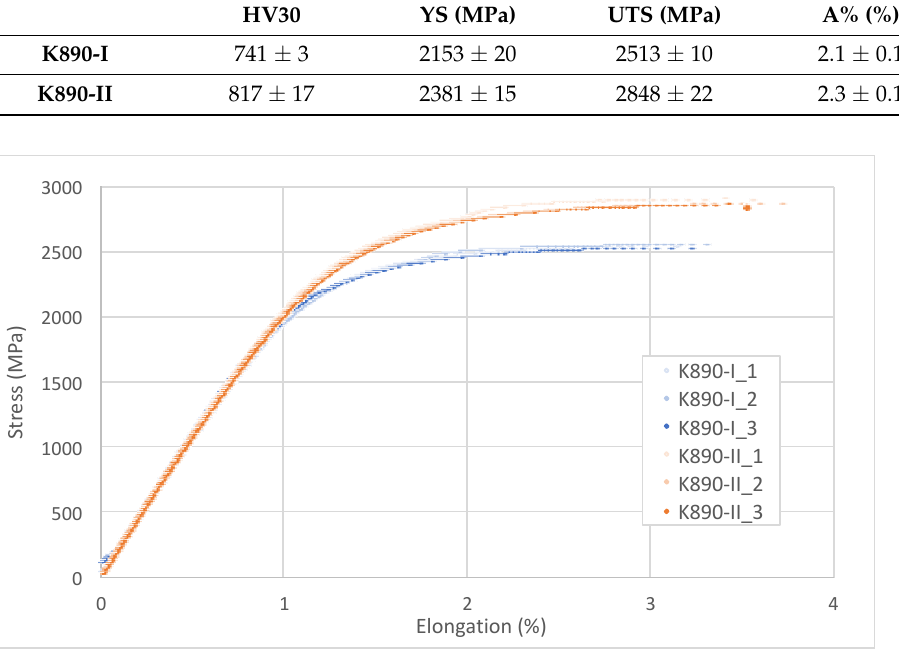
Table 2. Hardness and tensile properties (mean values and standard deviations) of the K890 steel